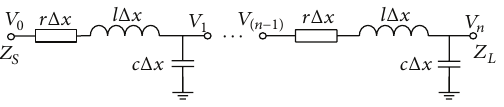
Figure 1: Transmission line equivalent model.